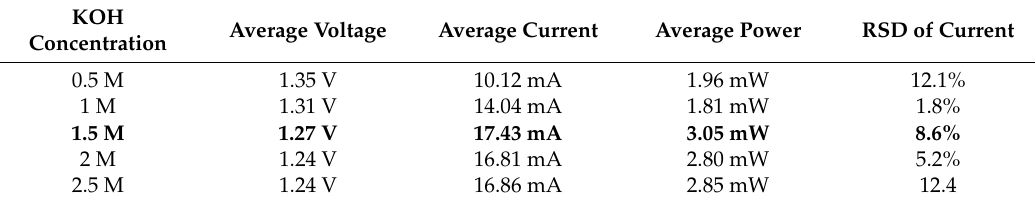
Table 6. Voltage, current, and power of a 9 cm 2 (3 cm × 3 cm) chip with aluminum area of 5.1 cm